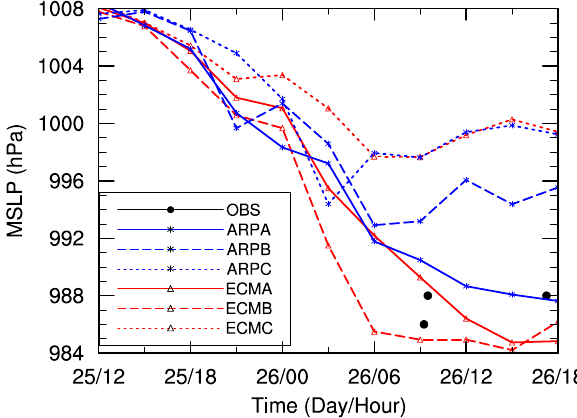
Fig. 2. Time evolution of MSLP minimum from 15:00 UTC 25 September to 18:00 UTC 26 September 2006; the black dots are values recorded at stations over land (Moscatello et al.,2008).